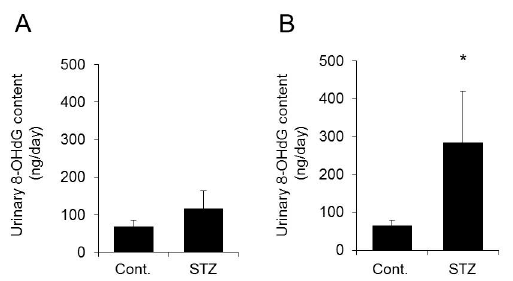
Figure 6. Urinary 8-hydroxydeoxyguanosine (8-OHdG) levels. Mice were given a single intravenous Figure 6. Urinary 8 ‐ hydroxydeoxyguanosine (8 ‐ OHdG) levels. Mice were given a single intravenous administration of STZ. After one week ( A ) or two weeks ( B ), the 8-OHdG concentration in the urine administration of STZ. After one week ( A ) or two weeks ( B ), the 8 ‐ OHdG concentration in the urine was measured (mean ± SD, n = 5, * p < was measured (mean ± SD, n = 5, * p < 0.05).